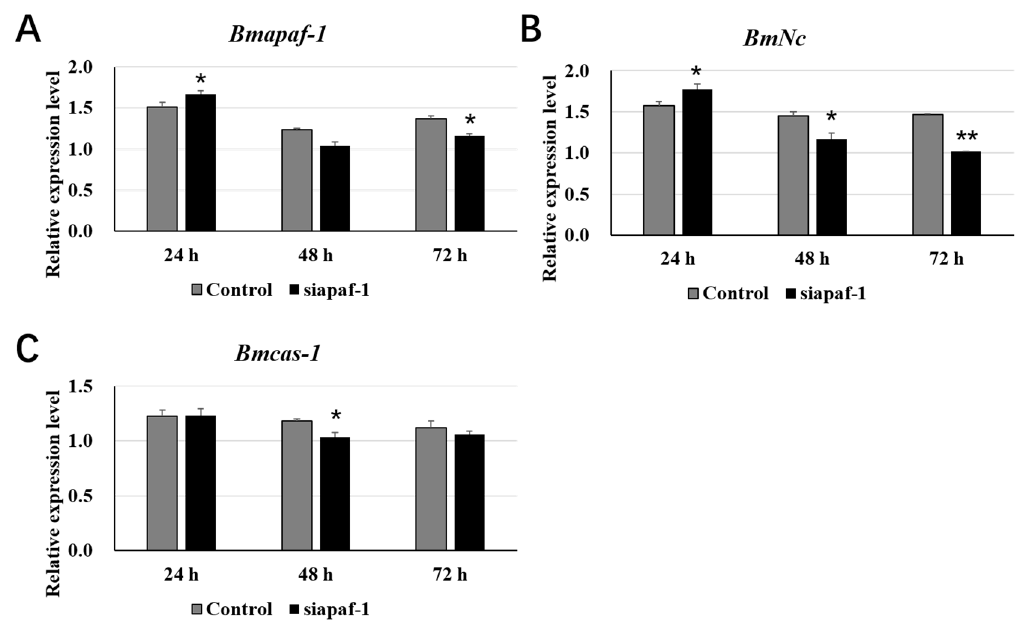
Figure 3. Expression analysis of selected downstream genes after knockdown of Bmapaf-1 with siRNA at different time points using RT-qPCR. ( A ) Expression level analysis of Bmapaf-1 after transfection with siRNA at 24, 48, and 72 h. Analysis of BmNc ( B ) and Bmcas-1 ( C ) expression levels after knockdown of Bmapaf-1 at different time points. BmGAPDH was used to normalize the data that were showed as the mean ± standard error, and the mean was from three independent repeats. The 2 − △△ Ct method was adopted to calculate the relative expression level. Differences among triple repeats were analyzed using the SPSS Statistics 20 software (IBM, USA) with the one-way ANOVA method. Asterisks represent the significant difference, as follows: * p < 0.05; ** p < 0.01.